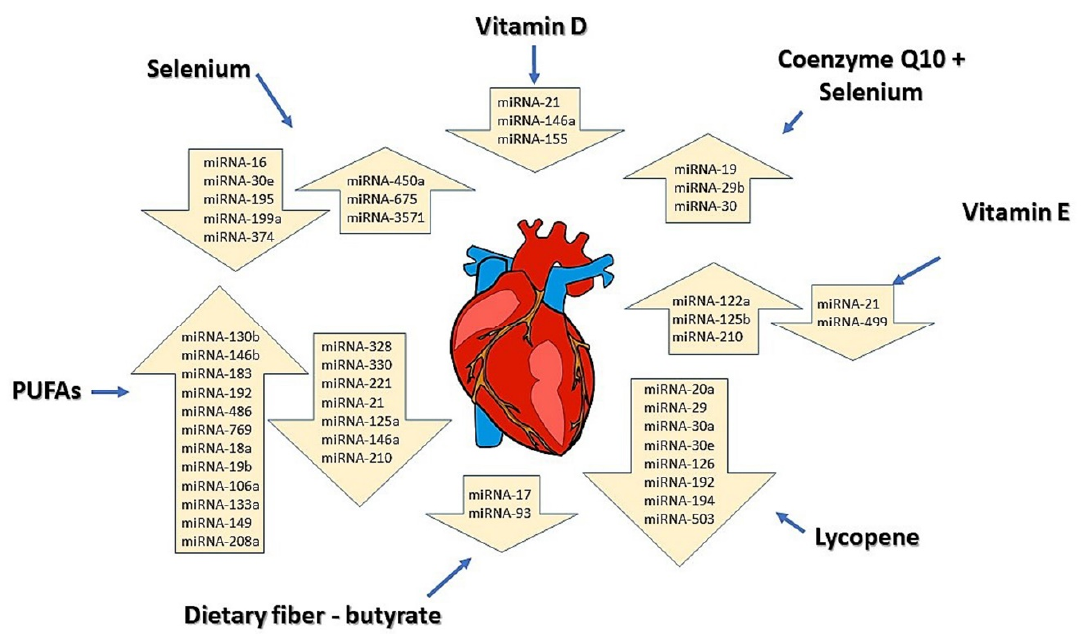
Figure 3. Selected bioactive dietary components and their modulation of miRNAs in the heart contribute to the prevention of CVD. In the arrows are placed miRNAs for which expression was changed in the diseased heart after individual nutrient administration. Upward arrows represent upregulation of miRNAs and downward arrows miRNAs which were downregulated. Changes in the expression of miRNAs shown in the figure were measured in CVD experimental models after administration of individual nutrients.